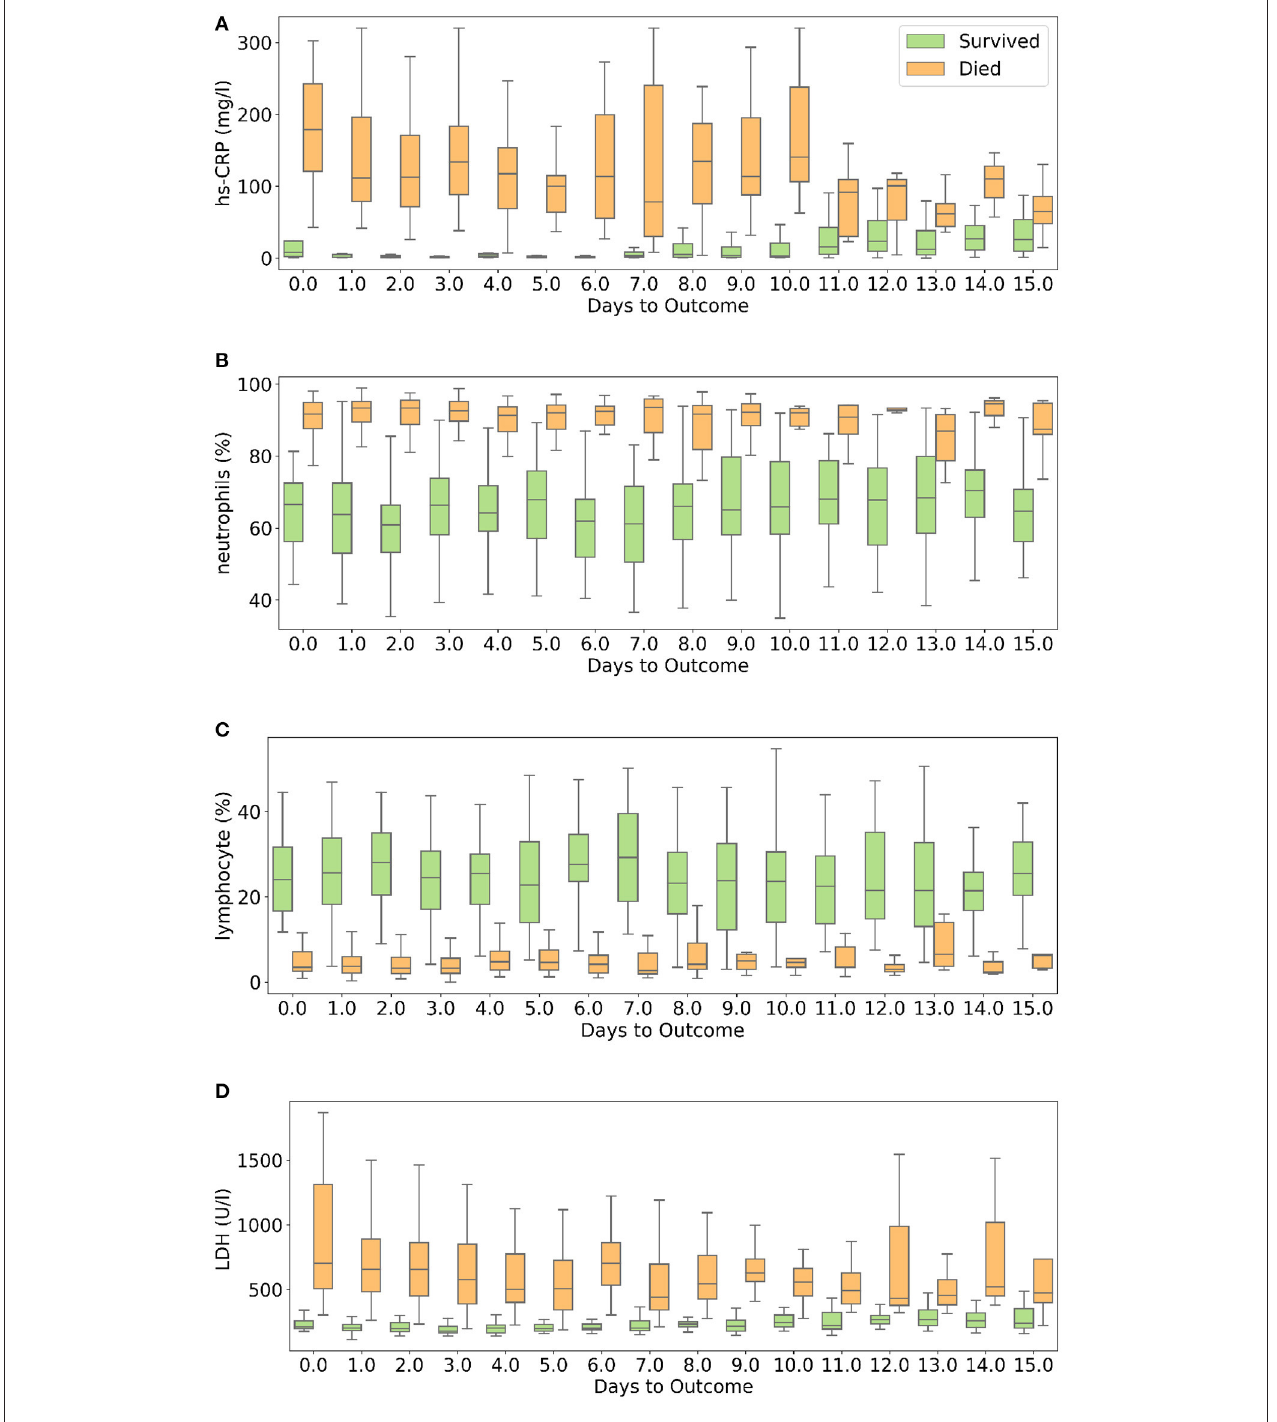
FIGURE 8 | Box and whisker plot showing the variations of four selected features with respect to the days to outcome. (A) hs-CRP, (B) neutrophils (%), (C) lymphocyte (%), (D) lactate dehydrogenase.